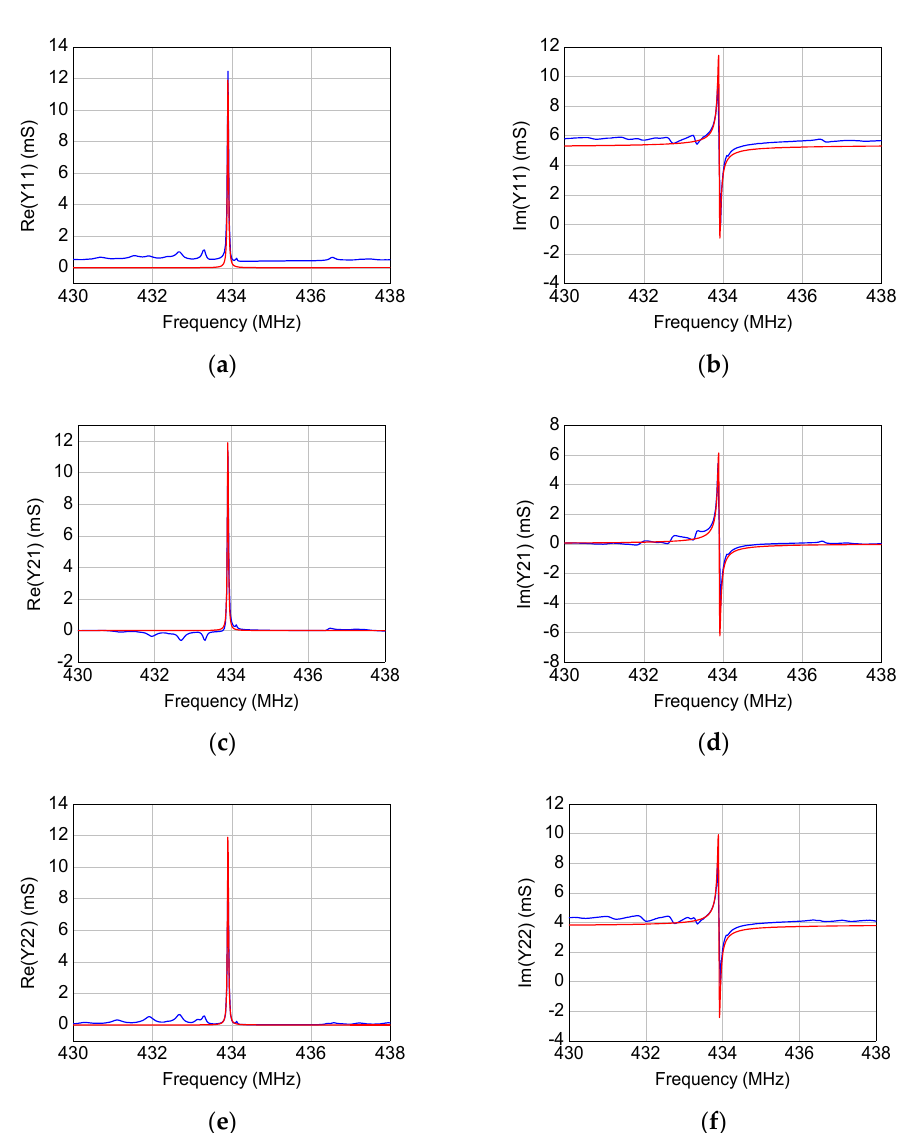
Figure 8. Comparison between (blue) measured and (red) simulated frequency-dependent behavior of ( a , b ) Y 11 , ( c , d ) Y 21 , and ( e , f ) Y 22 for the 433.92 MHz SAW resonator.